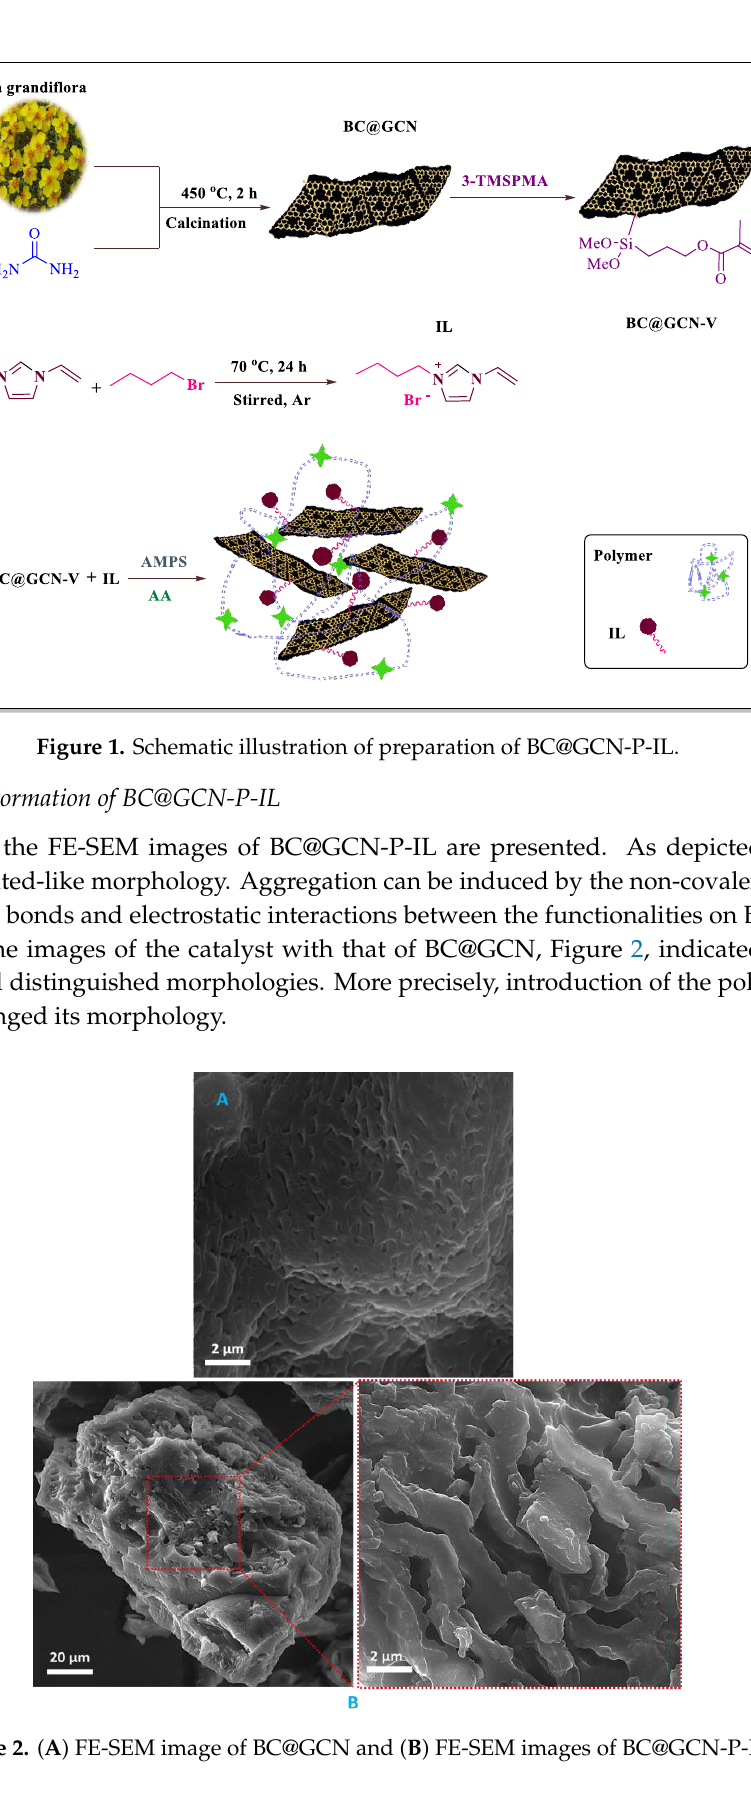
Figure 2. ( A ) FE-SEM image of BC@GCN and ( B ) FE-SEM images of BC@GCN-P-IL.